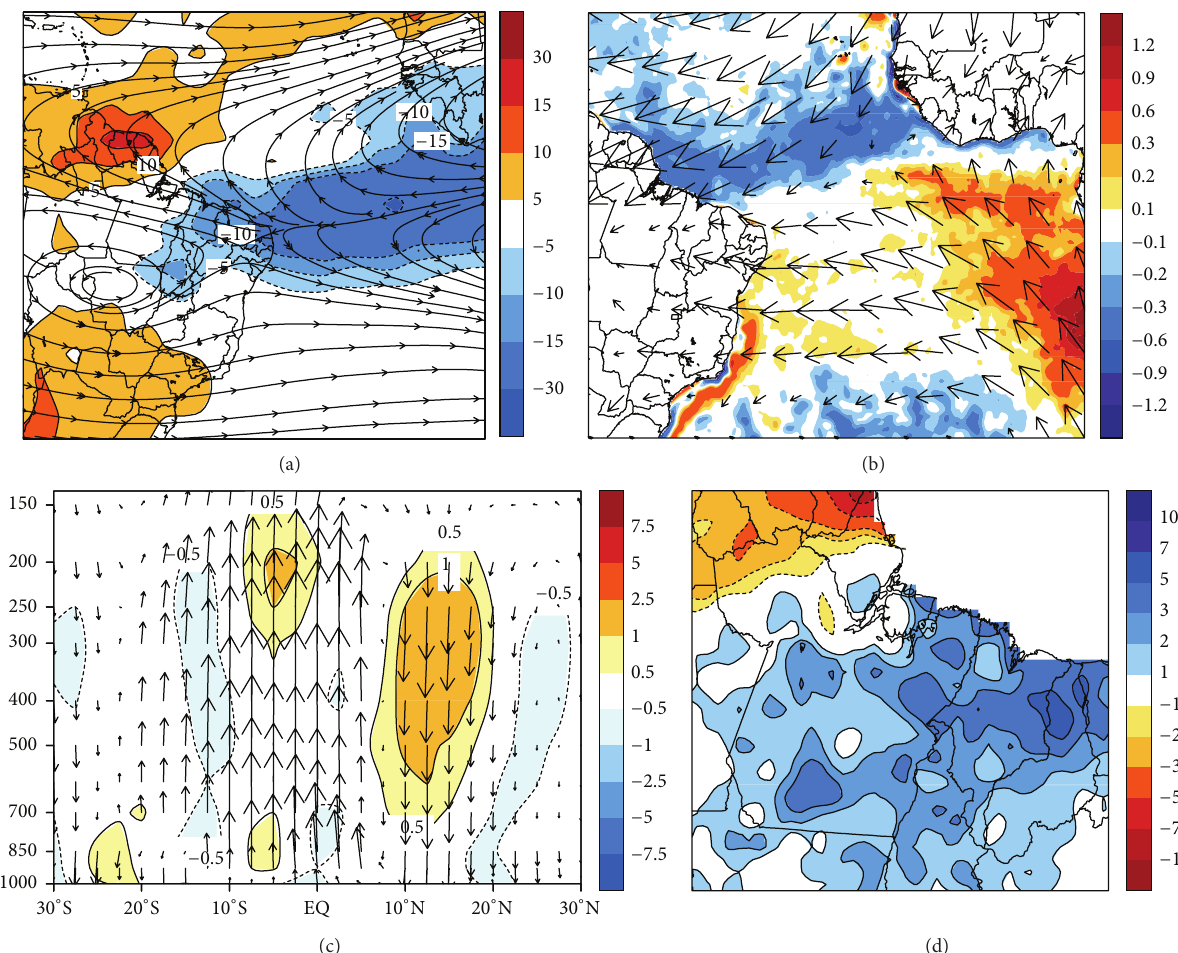
Figure 6: As in Figure 4, but for April composites, corresponding to the objectively selected events in the